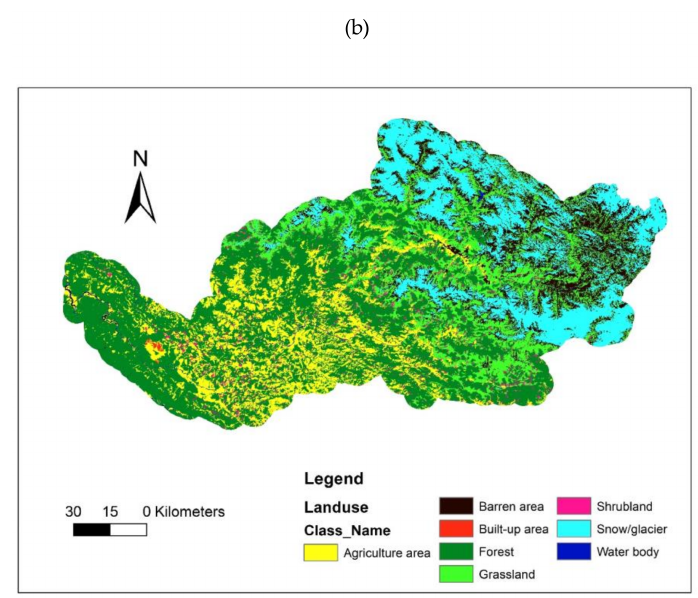
Figure 2. ( a ) Soil types ( top ) and ( b ) Land use ( bottom ) maps of the Bheri River